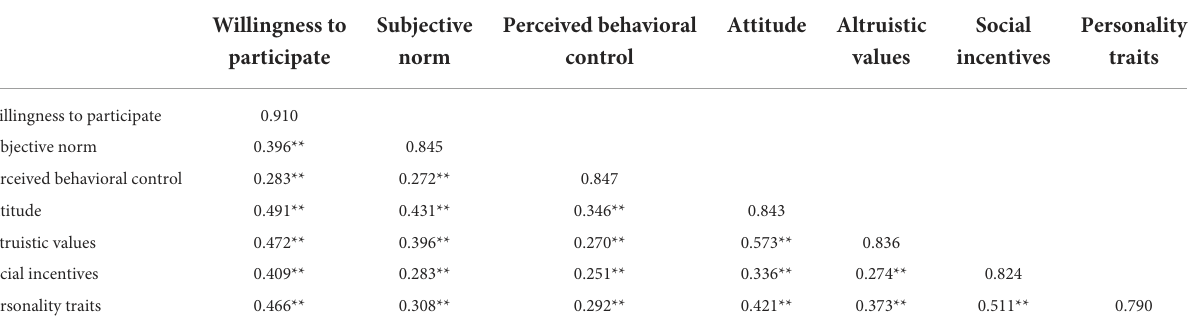
TABLE 5 Discriminant